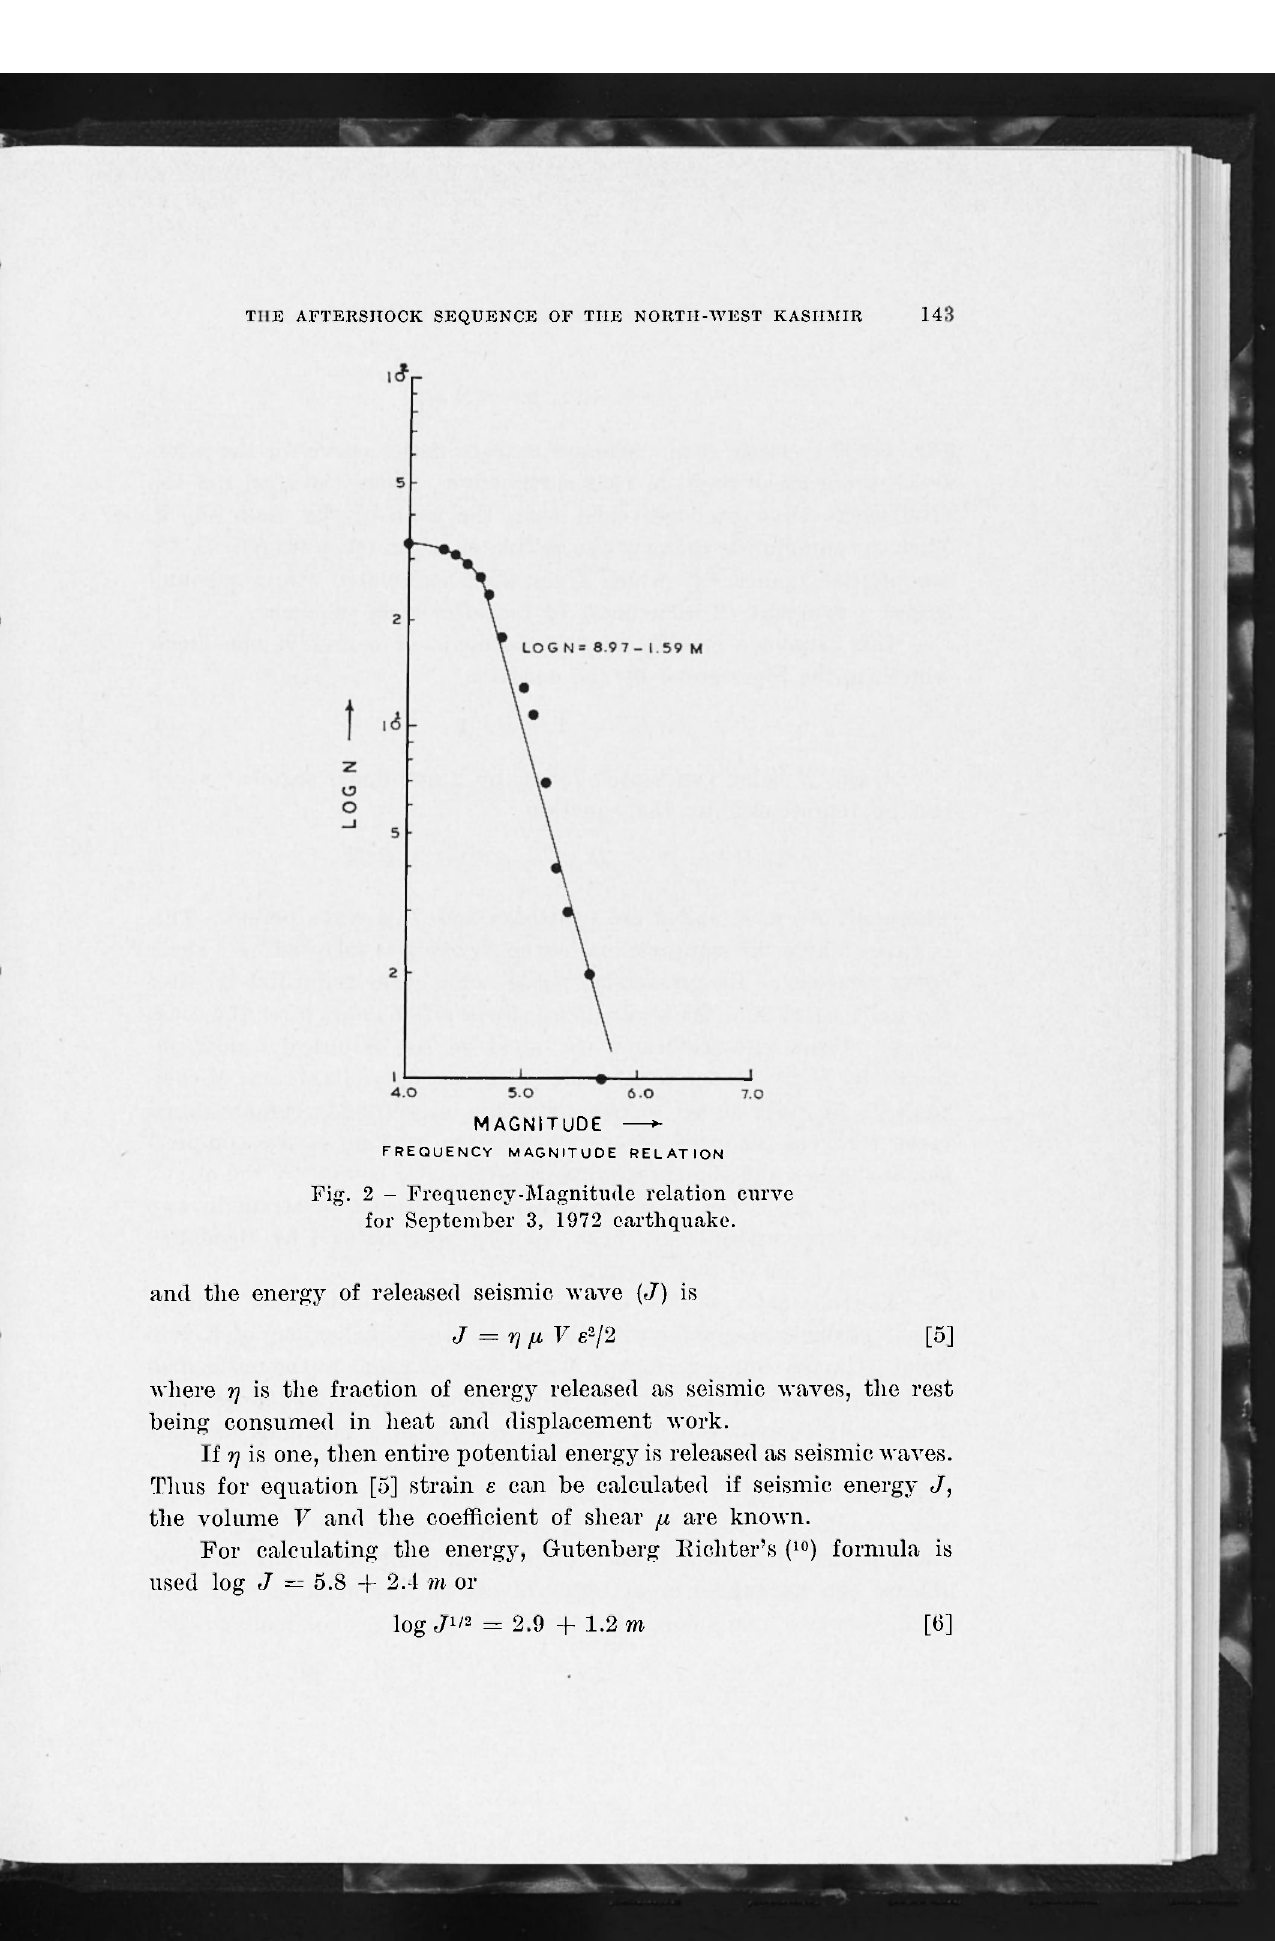
Pig. 2 - Frequency-Magnitude relation curve for September 3, 1972